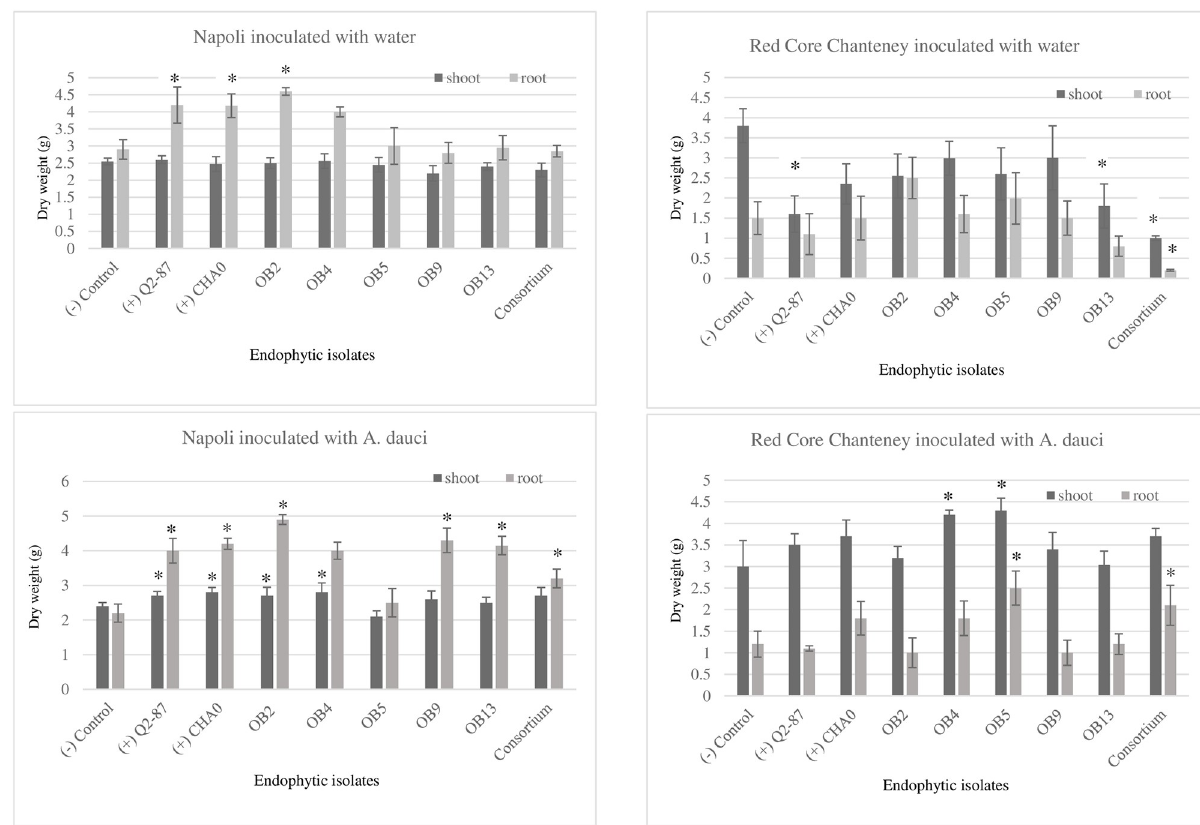
Fig 4. Shoot and root weight of two carrot varieties treated with endophytic bacterial isolates as a seed treatment and inoculated with water or A . dauci in a greenhouse trial. Stars indicate significant differences between the endophyte treatment and the negative control within each genotype by pathogen treatment and shoot and root category ( P < 0.001).